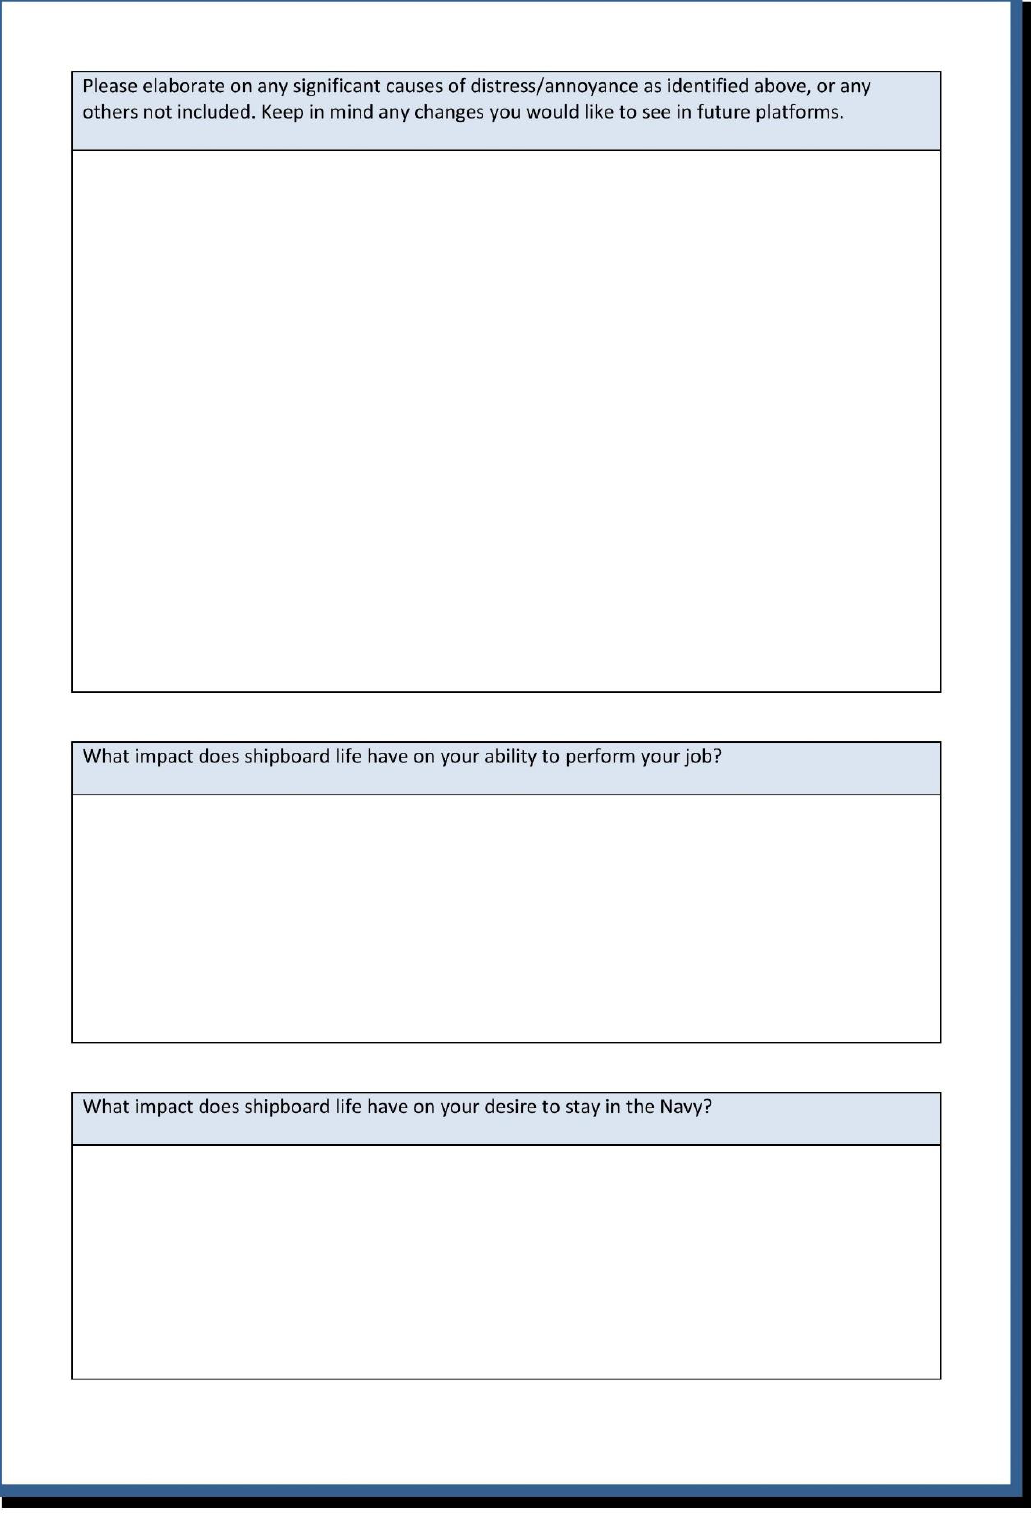
Figure A15. The Submarine Habitability Assessment Questionnaire (continued).